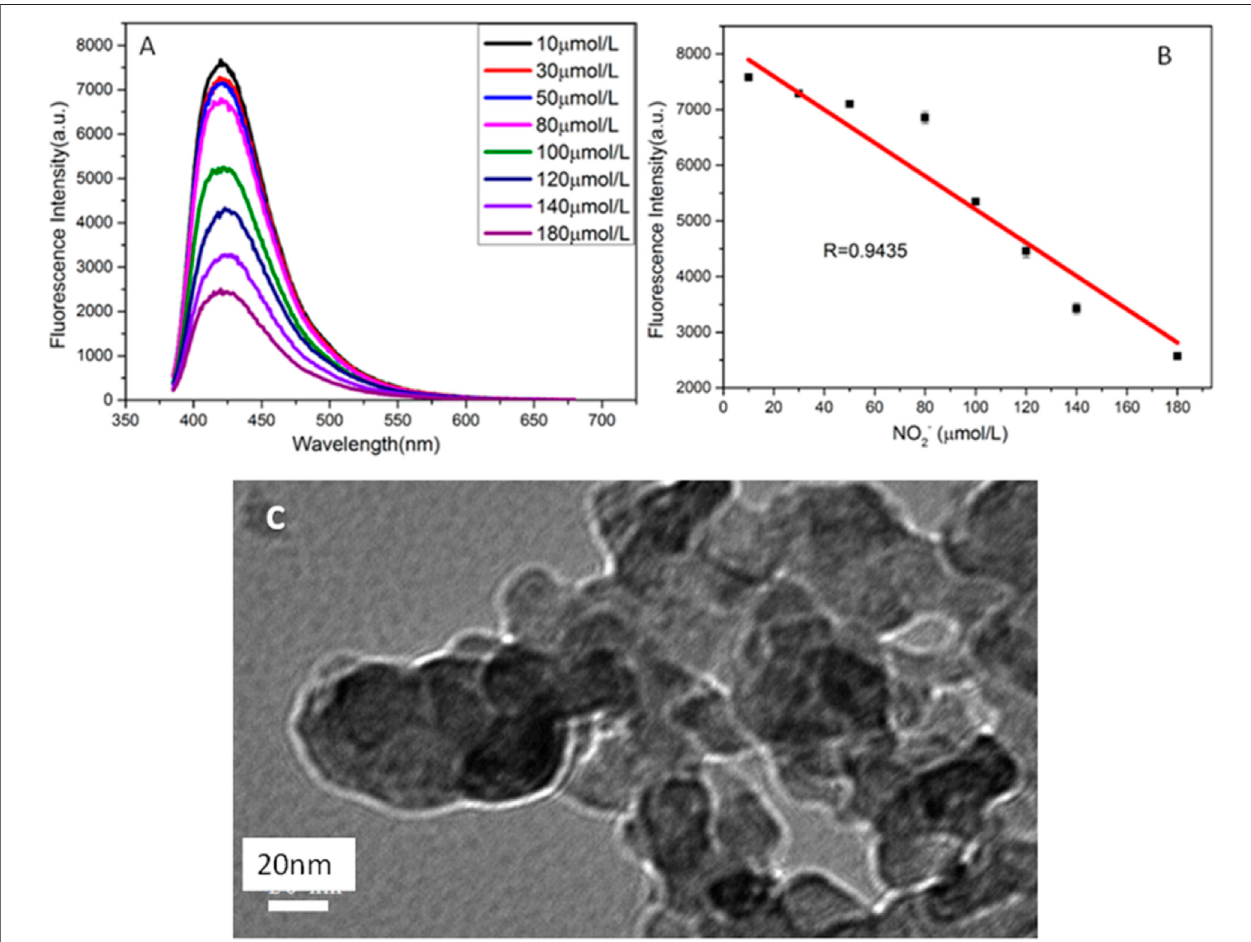
FIGURE6|(A) FluorescencespectraofCuNPsobtainedwithdifferentconcentrationsofNO 2 − (fromtoptobottom:10,30,50,80,100,120,1,400,and180 μ mol/ L, respectively); (B) relationship between F and the concentration of NO 2 − ; (C) TEM of copper nanomaterials after adding NO 2 − .